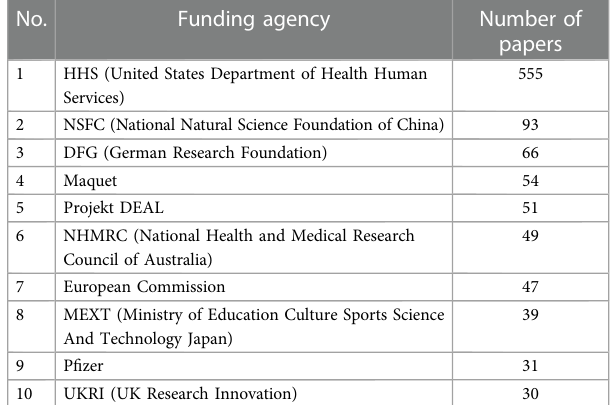
TABLE 1 Top 10 funding sources for ECMO research papers. No.